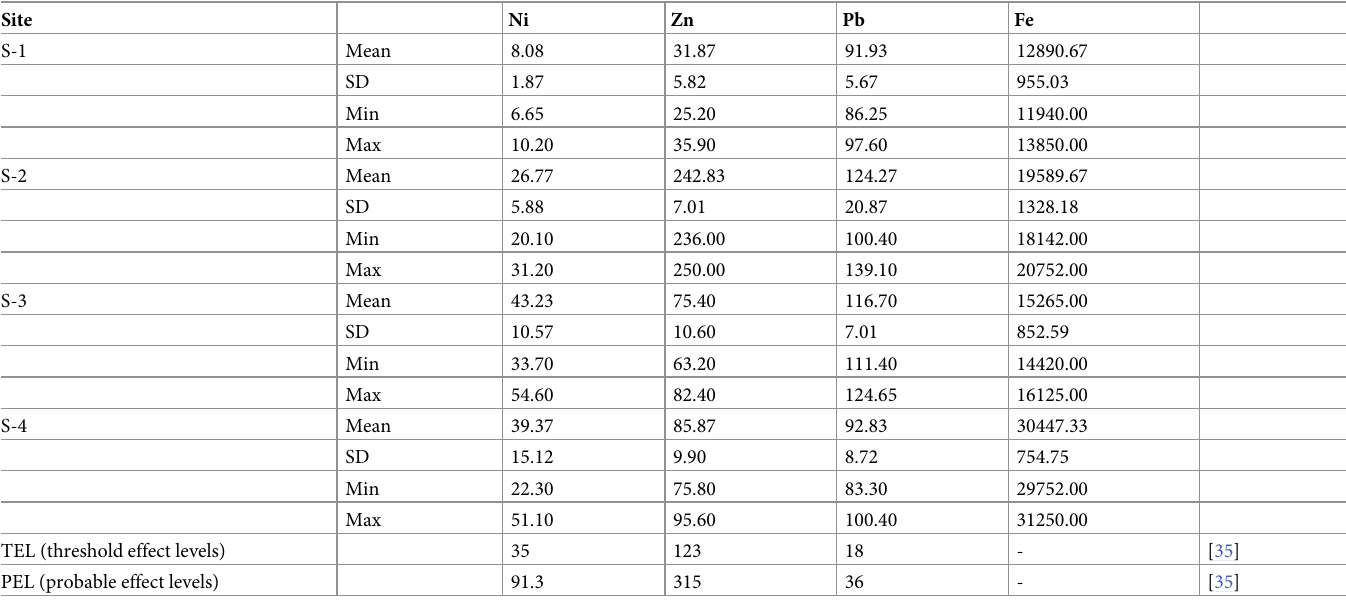
Table 1. Statistical summary of heavy metals (mg/kg) in river Bharalu sediments. Site